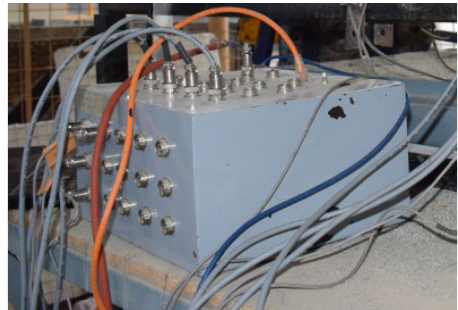
Figure 11. A 30-channel data logger.